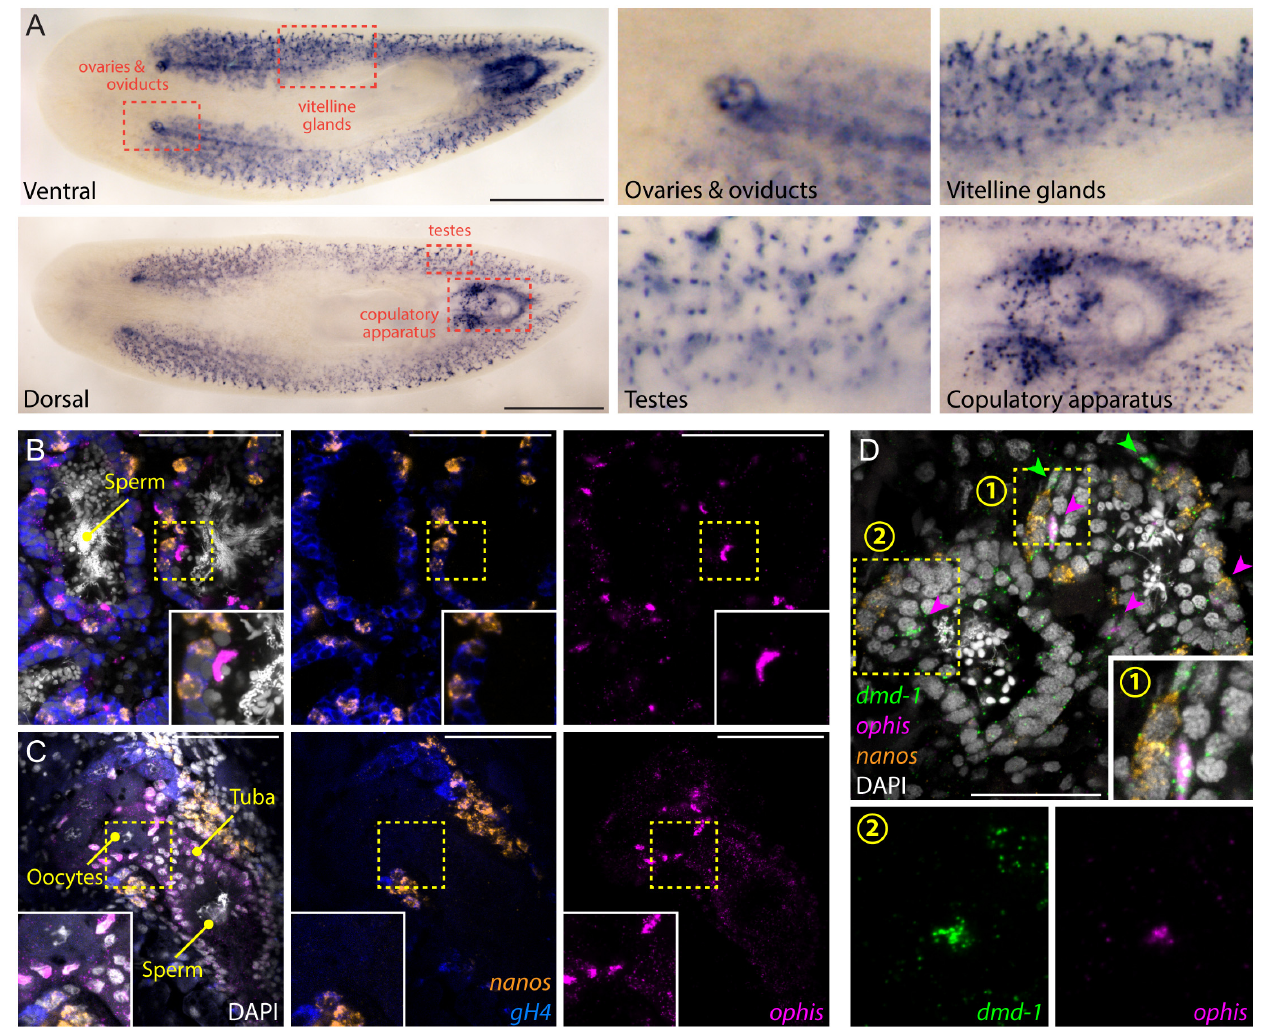
Fig 6. ophis is expressed in the somatic gonadal niche. (A) Colorimetric ISH shows expression of ophis in somatic reproductive structures. Insets show magnified view of specific tissues indicated by red dashed boxes. (B and C) Triple-FISH labeling ophis (magenta), gH4 (blue), and nanos (orange). Within gonads, ophis expression is exclusive to somatic cells in the periphery of testis lobes (B) and in presumptive follicular cells of the ovaries (C). (D) Triple-FISH labeling ophis (magenta), nanos (orange), and dmd-1 (male somatic gonad cells, green) in the testes. ophis and dmd-1 are co-expressed inside testes (magenta arrowheads). dmd-1 + /ophis - cells can be seen outside the testes (green arrowheads). Insets 1 and 2 show magnification of regions indicated by numbered yellow dashed boxes. DAPI (grey) labels nuclei in B – D. Scale bars are 1 mm in A, 100 μ m in B and C, and 50 μ m in